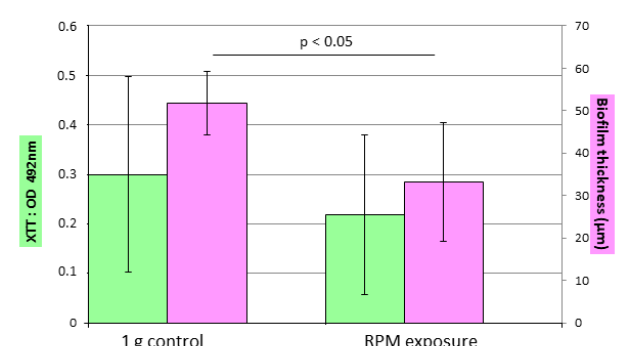
Figure 5. Impact of microgravity on biofilm formation. Evaluation of biofilm formation using the XTT test (green) and confocal microscopy to measure biofilm thickness (pink) in 1 g control and simulated microgravity conditions. Duplicates of the CBS 124630 strain were subjected to 1 g control or RPM conditions. Experiments were performed five times. Data are the mean ± SEM. Statistically significant differences were observed using the Student’s t test.